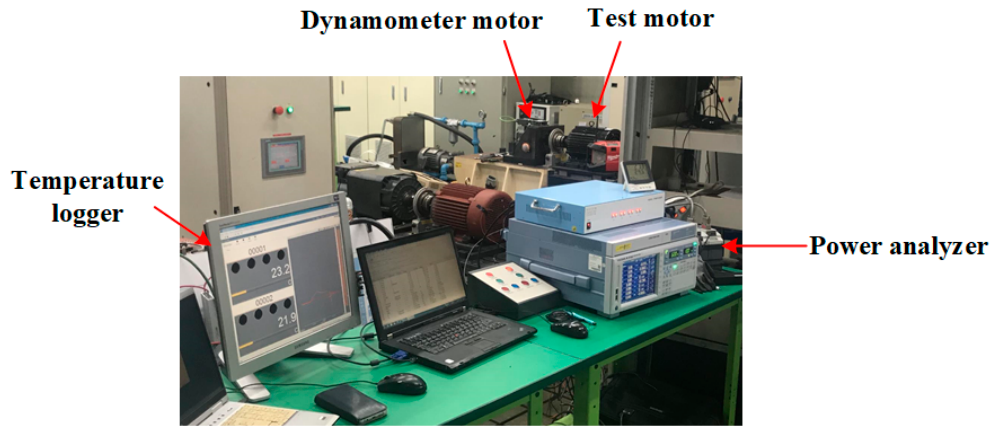
Figure 15. The experiment environment and test dynamometer. Table 8. Comparison of FEA and experiment result.